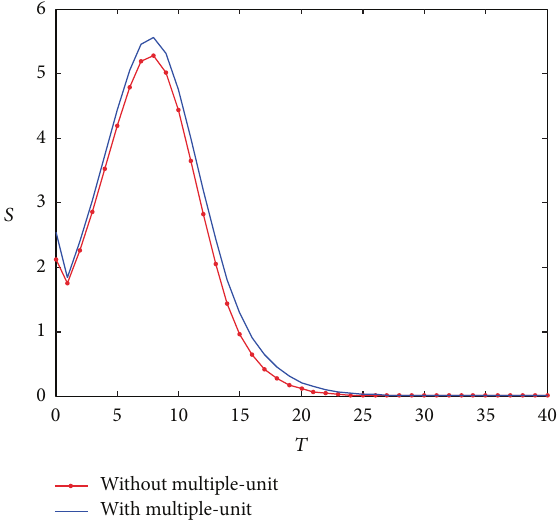
Figure 3: Impact of multiple-unit ownership on the